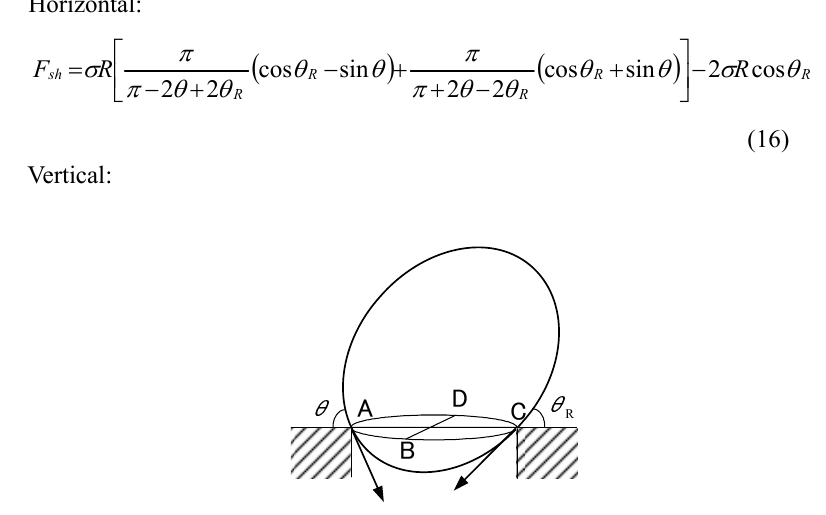
Fig.7 Surface tension acting on the contact